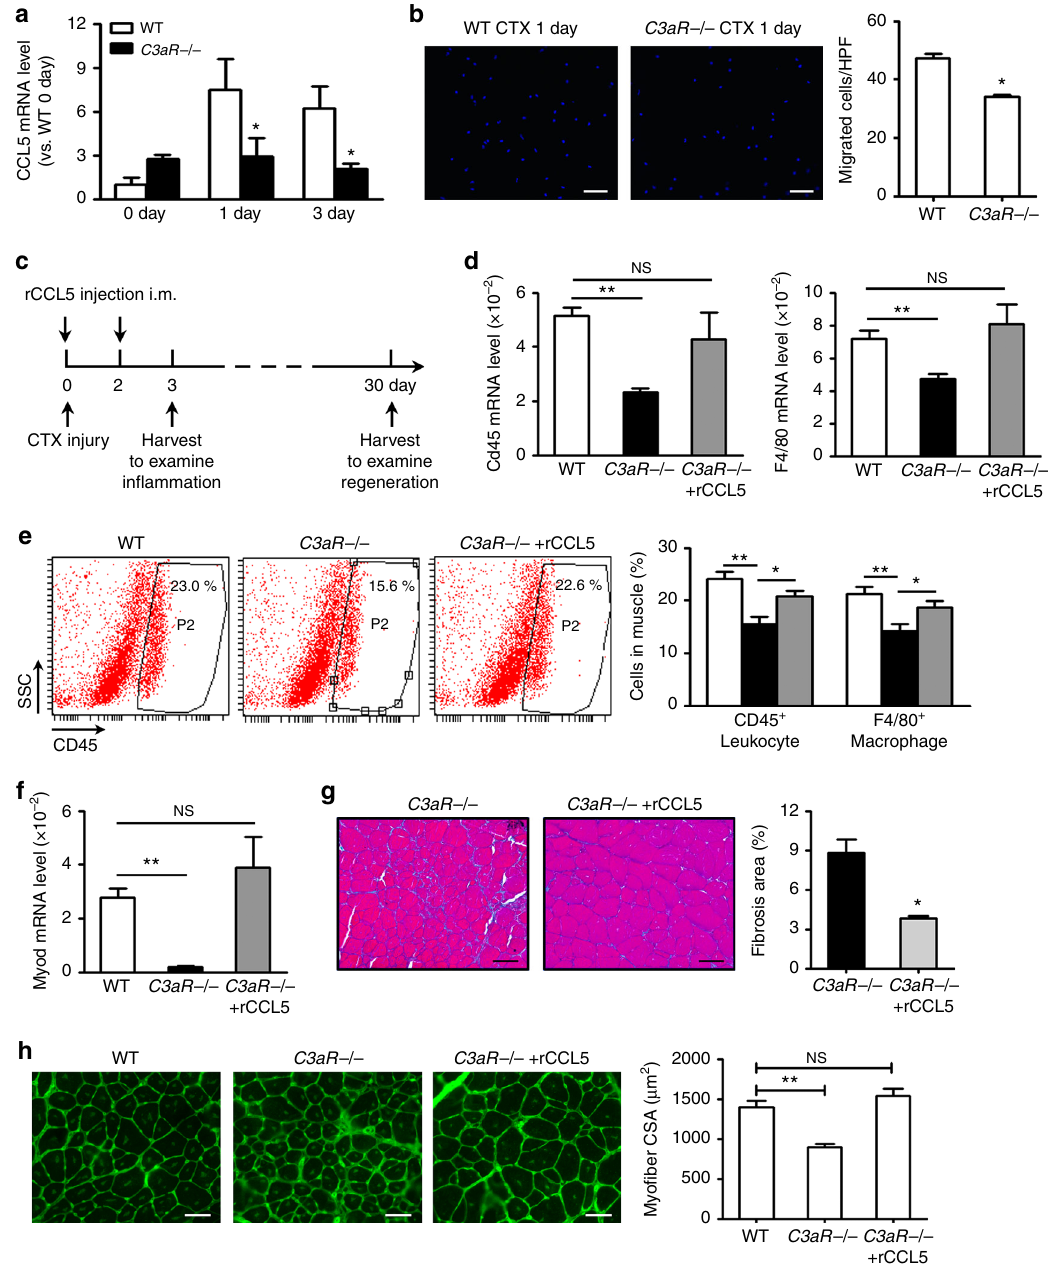
Fig. 7 Recombinant CCL5 rescued the impaired muscle regeneration of C3aR − / − mouse. a At day 0, 1, 3 after injury, mRNA levels of cytokines CCL5 in WT and C3aR − / − muscles were accessed by real-time PCR. ( N = 4 in each group). b At day 1 after CTX injury, WT ( N = 8) and C3aR − / − ( N = 4) muscle extract were seeded in the lower chamber and WT monocytes (5 × 10 4 /well) were seeded in the upper chamber. Twelve hours after co-culture, migrated cells from upper chamber were counted by DAPI staining (blue). (Bars, 50 μ m, ten fi led was collected per sample). c Schematic diagram of the protocol. Recombinant mouse CCL5 (0.1 mg kg − 1 ) was intramuscular injected to C3aR − / − muscle at day 0 and day 2 after CTX injury. At day 3 after injury, TA muscle was harvested to examine the in fl ammation response, and at day 30 after injury, TA muscle was harvested to examine the regeneration. d mRNA levels of CD45 and F4/80 in WT, C3aR − / − and C3aR − / − with rCCL5 muscles were accessed by real-time PCR. ( N = 4 in each group). e CD45 + leukocytes and F4/80 + macrophages in muscles were detected by FACS. The right graph indicated the percentages of CD45 + leukocytes and F4/80 + macrophages ( N = 4 in each group, graphs show representatives of two independent experiments). f mRNA levels of MyoD in WT, C3aR − / − and C3aR − / − with rCCL5 muscles were accessed by real-time PCR. ( N = 4 in each group). g Masson staining was used to detect the collagen deposition (green color) in muscle (at day 15 after injury) of WT and C3aR − / − mice, the percentages of fi brosis area per fi eld were analyzed. (Bars, 50 μ m; N = 4 in each group). h The mean myo fi ber CSA in injured muscles from WT, C3aR − / − and C3aR − / − with recombinant CCL5 mice at day 30 after injury were measured. ( N = 4 in each group, bars, 50 μ m). Data are expressed as the mean ± s.e.m. * P < 0.05, ** P < 0.01, unpaired t -test,